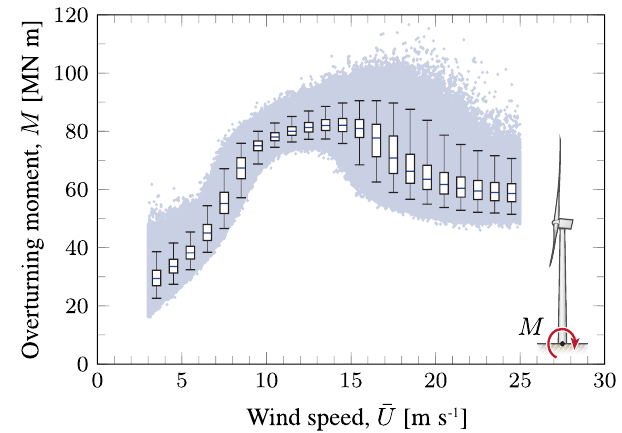
Figure 1. The data set, containing over 5 million 10min extreme overturning moments between the cut-in and cut-out wind speeds. The box plots indicate the scatter per 1ms − 1 bin, where the boxes mark the 25th and 75th percentiles, the whiskers mark the 2.5th and 97.5th percentiles, and the bar is the